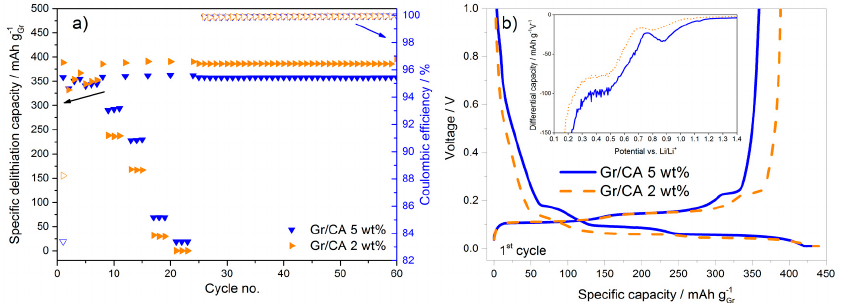
Figure 6. Electrochemical performance of coated graphite electrodes with 5 wt % and 2 wt % carbon- coating made using citric acid as a precursor. ( a ) C-rate test and constant cycling at C/2 (the arrows point at the corresponding y axes, closed symbols represent capacity, open symbols–coulombic efficiency); ( b ) first cycle voltage profile (inset: differential capacity plot for the first cycle).